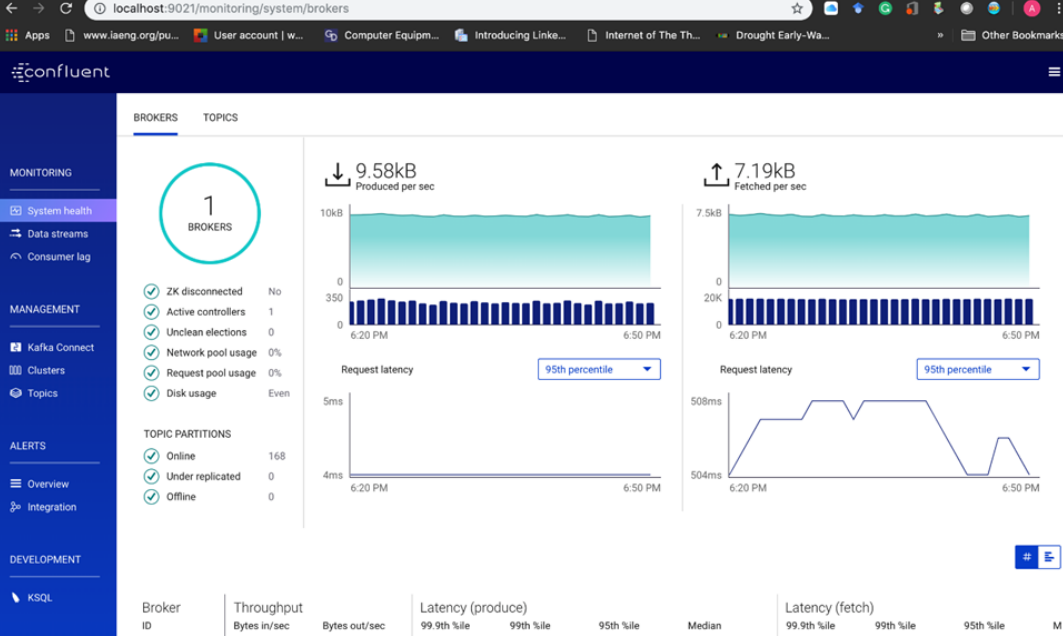
Figure 11. The Confluent platform